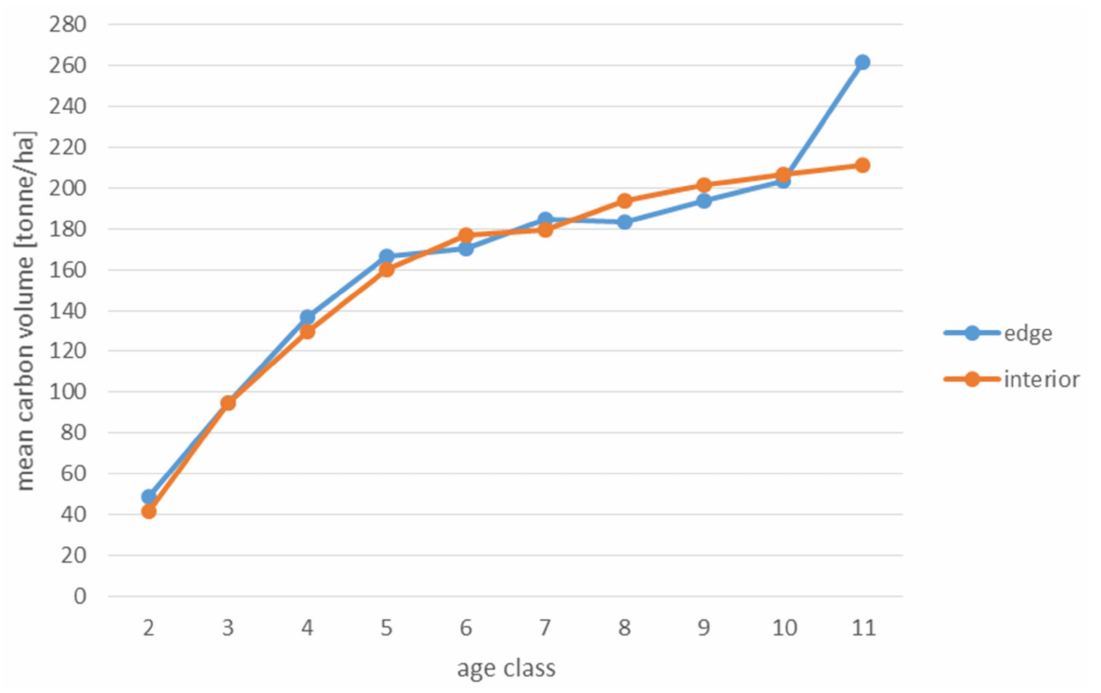
Figure 7. Changes in the mean carbon volume density in the site of FMCF, divided into the edge and interior zone.